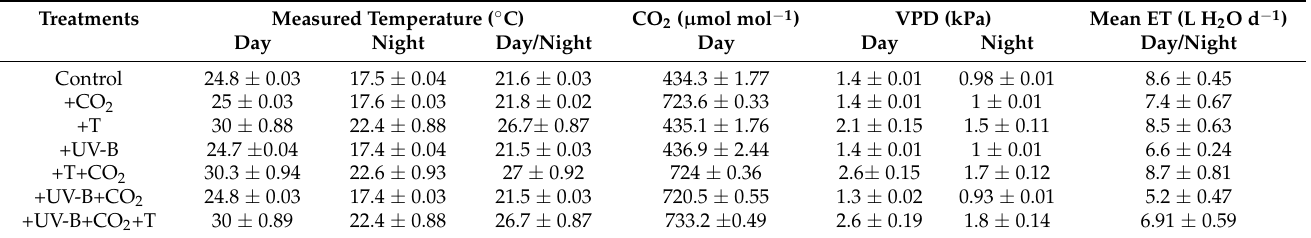
Table 1. The set treatments and measured day, night, and average temperatures, chamber carbon diox- ide concentration (CO 2 ), daytime and nighttime vapor pressure deficit (VPD), and evapotranspiration (ET) during the experimental period of each treatment in kale and